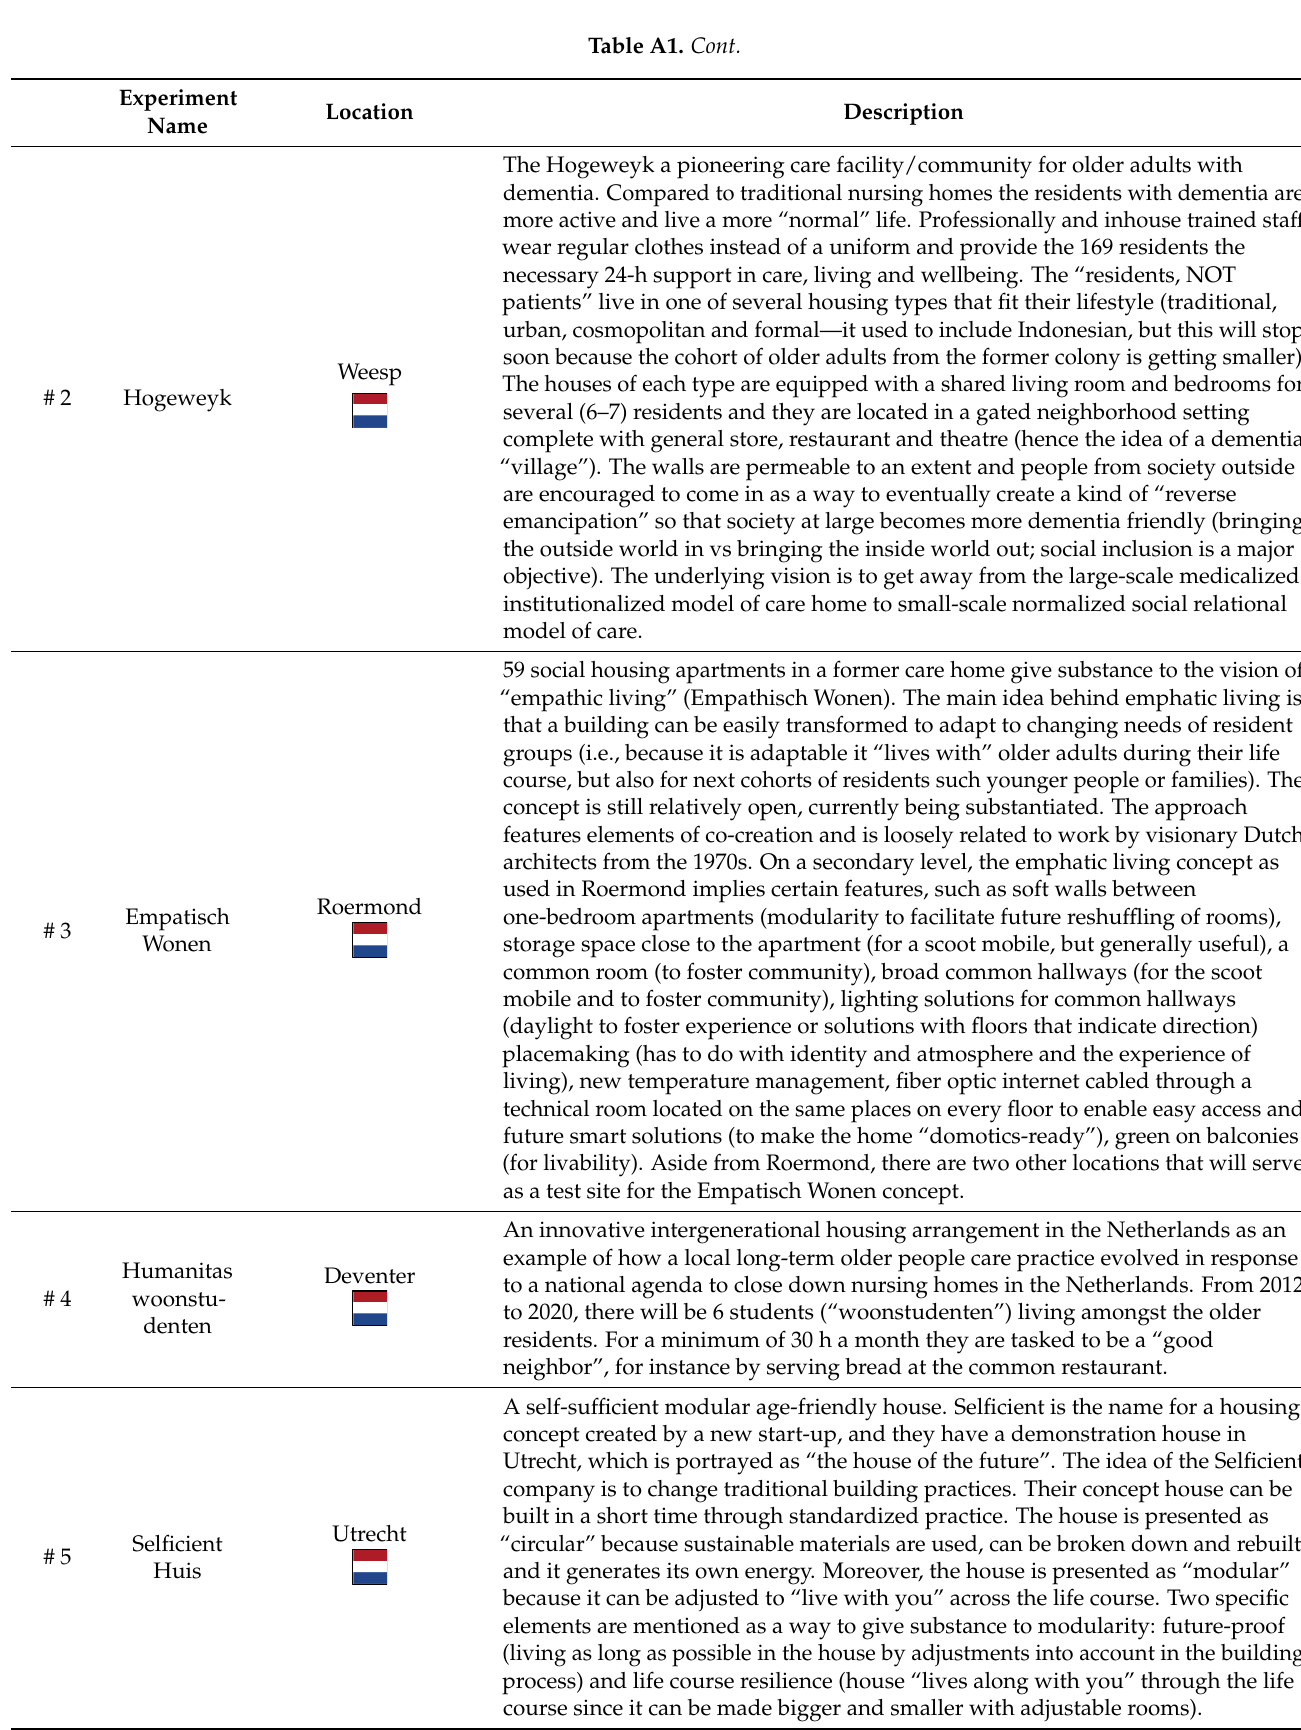
Table 2. Overview of 8 key age-friendly home experiments in the Netherlands, France, Ireland and Poland (see Table A1 in Appendix A for the complete overview of 53 experiments). Table A1. Cont.